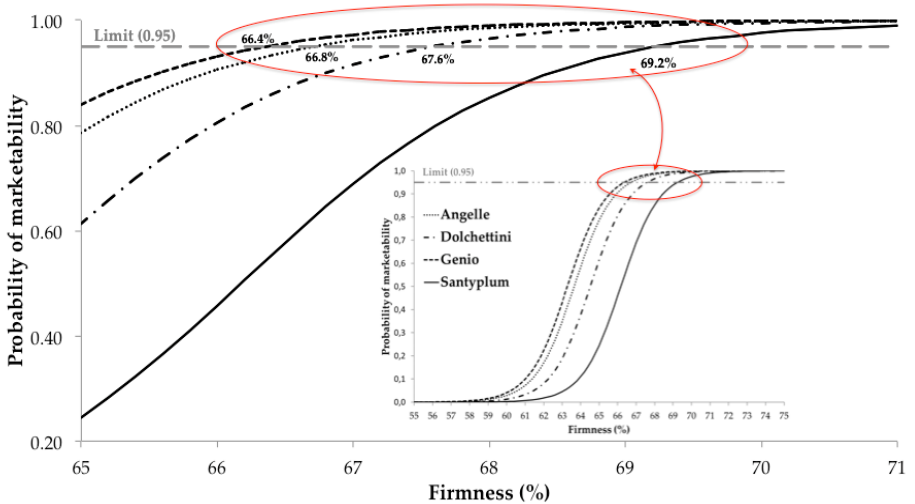
Figure 4. Temporal evolution of the marketability probability based on firmness in the cultivars ‘Angelle’, ‘Genio’, ‘Dolchettini’, and ‘Santyplum’.